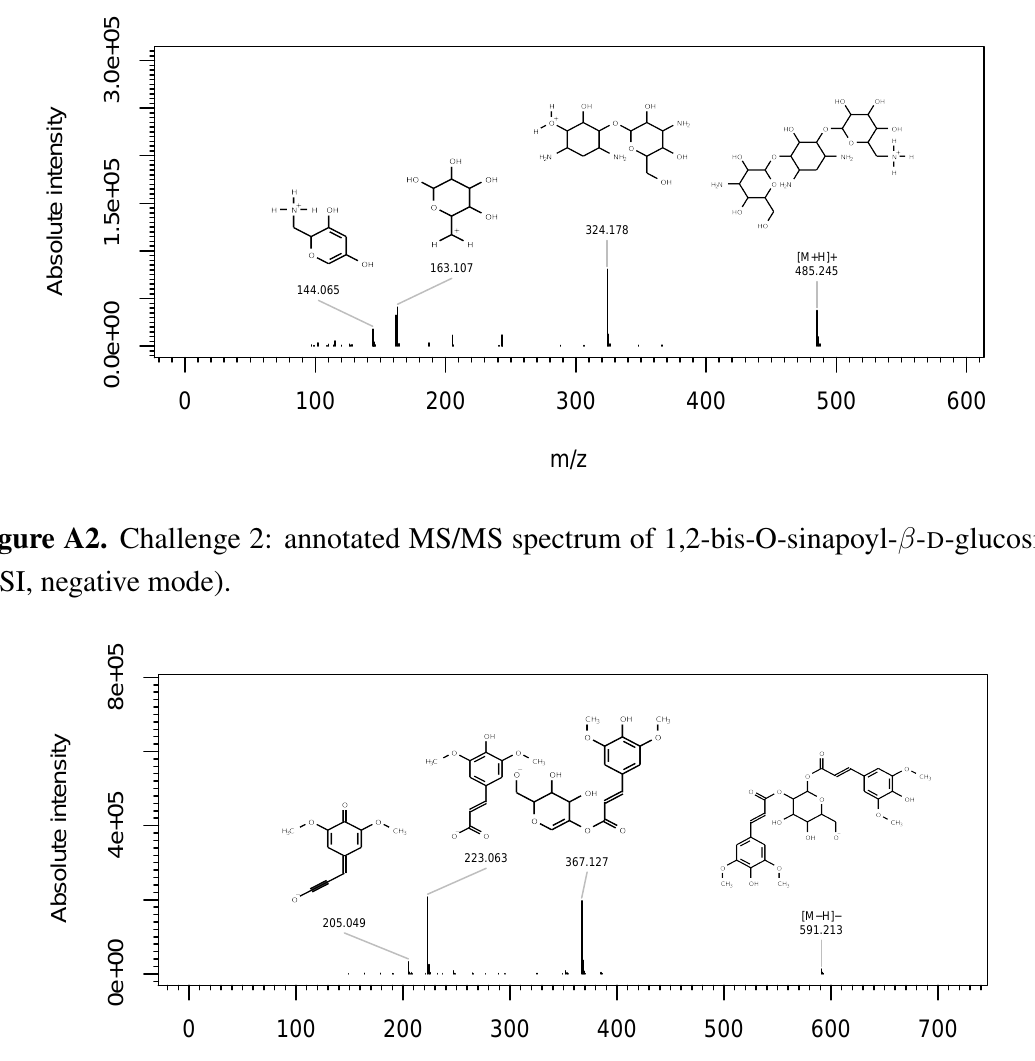
Challenge 1: annotated merged MS and MS/MS spectra of kanamycin A (electrospray ionization (ESI), positive mode).